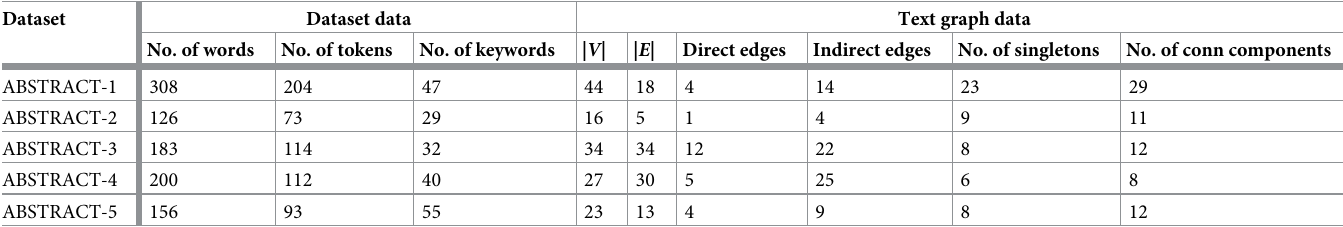
Table 8. Statistical and text graph data of each abstract in the HULTH dataset. Number of words and number of tokens denote the number of words in the dataset before and after preprocessing respectively. Direct edges and indirect edges represent the number of direct and indirect synonym relationships between words in the text graph